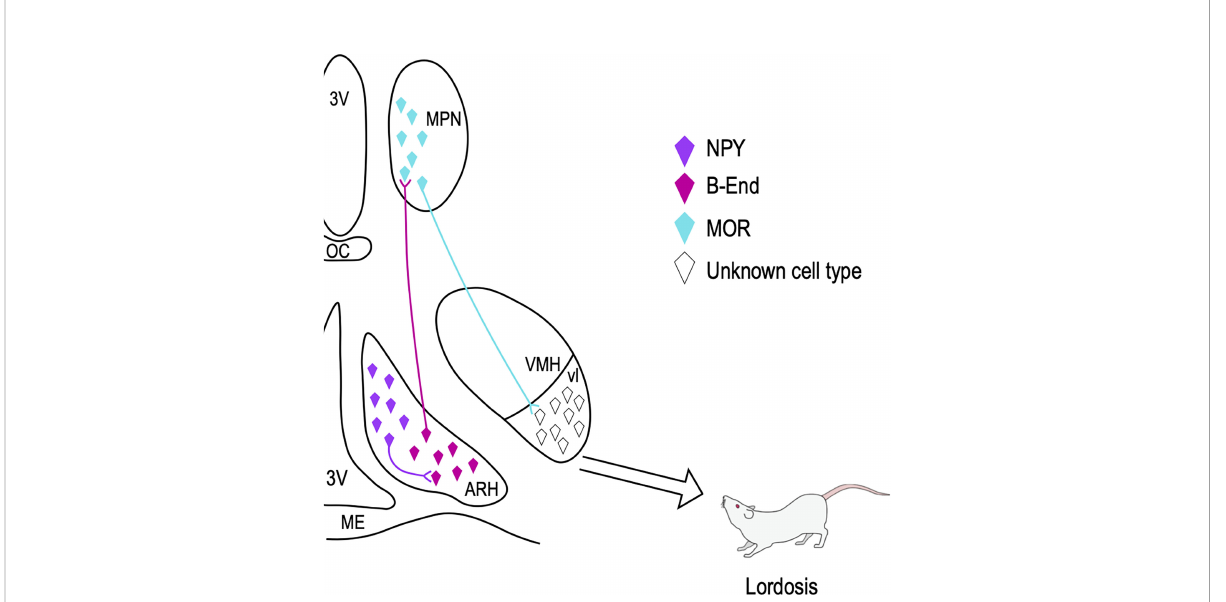
FIGURE 2 Hypothalamic lordosis circuit. Estradiol acts on estrogen receptor-containing NPY neurons in the ARH, which further project to and activate ARH POMC/B-End neurons. These POMC neurons project to the MPN where the release of B-End activates and internalizes MORs. When these receptors are internalized, lordosis is attenuated. In the ARH, the interaction of mER a & mGluR1a is important for both the internalization of MOR and ultimately the display of lordosis. These MOR-containing neurons in the MPN project further to the ventrolateral (vl) part of the VMH, where signals from other circuits are integrated. Projections from the VMHvl reach lower brain regions which ultimately innervate the spinal motor neurons responsible for the production of the behavior. 3V, 3rd ventricle; OC, optic chiasm; ME, median eminence. Figure adapted from